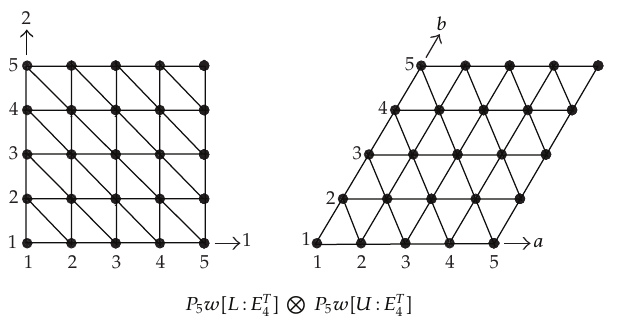
Figure 10: Transformation between Cartesian and oblique coordinate systems.